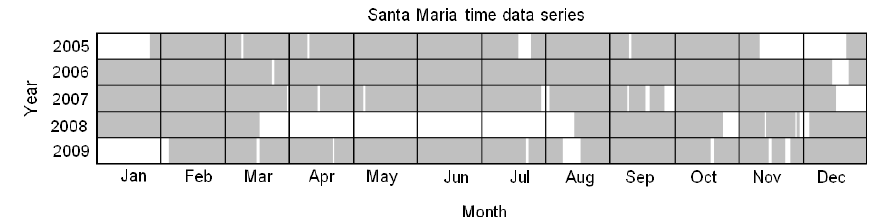
Fig. 3. The same as Fig. 1 but for the meteor radar at SM.